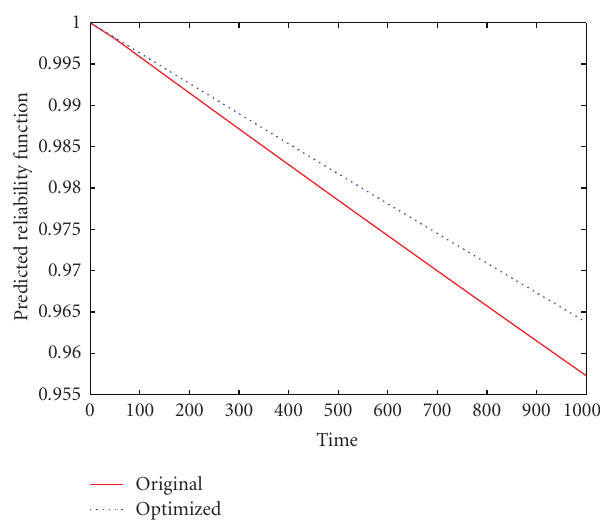
Figure 9: Reliability functions